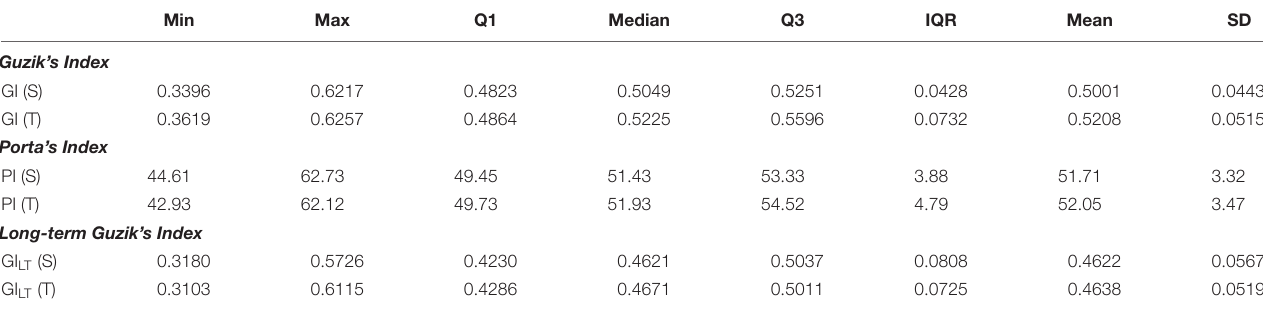
TABLE 3 | Descriptive statistics of rate asymmetry descriptors: Guzik’s index and Porta’s index dispersion among participants during HUTT in supine (S) and tilt (T)